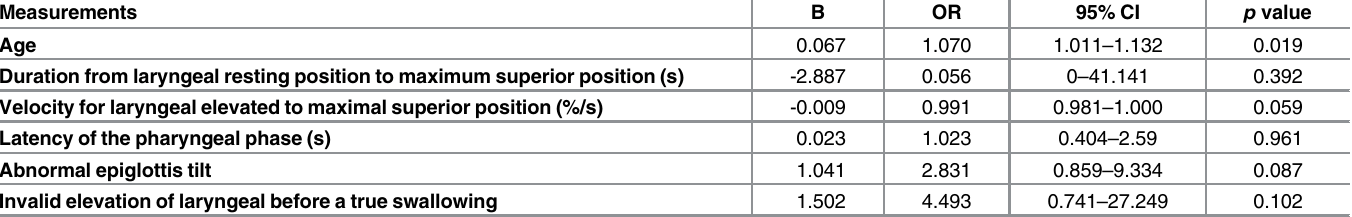
Table 3. Results from the logistic regression analysis of VFS indices identified from previous univariate analysis and their association with PAS equal to or greater than 5, including the velocity and duration for the laryngeal elevated to maximal superior